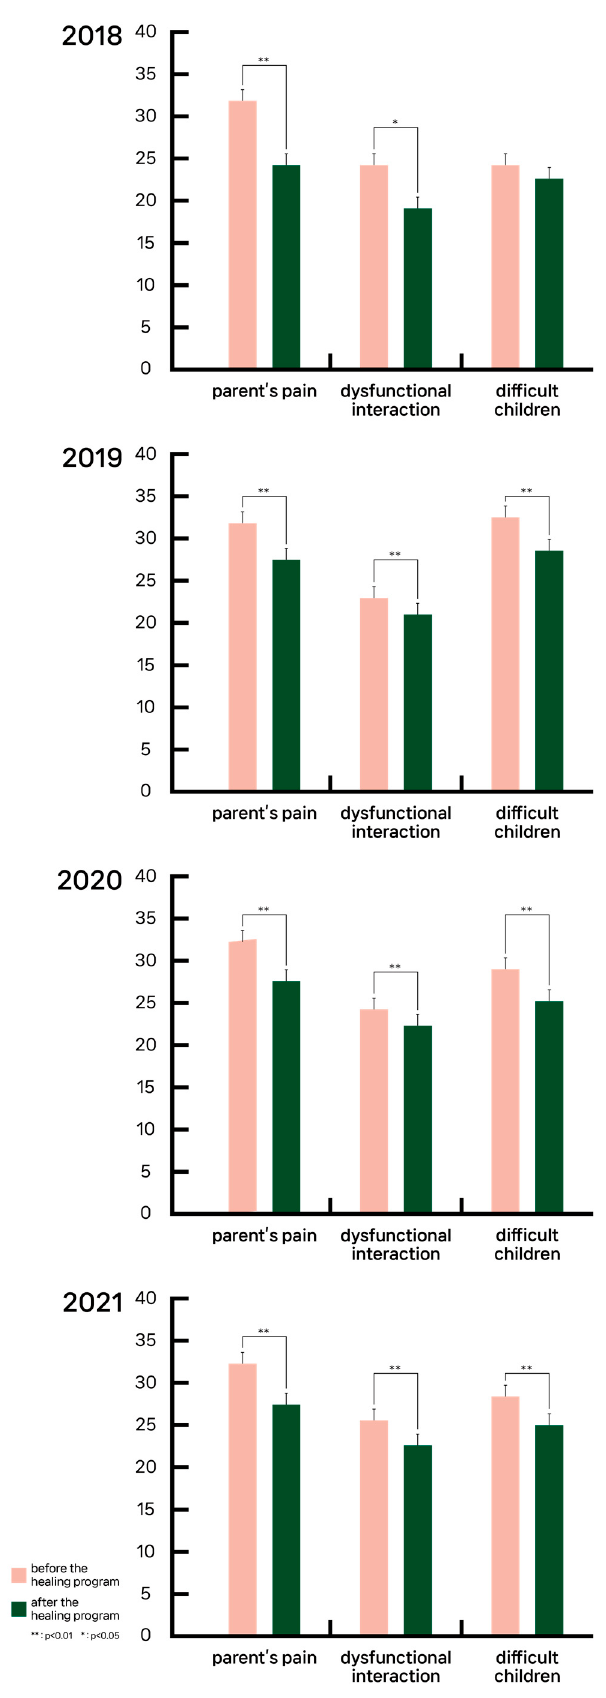
Figure 4. Results of K-PSI-SF subdomains for each year 2018–2021.